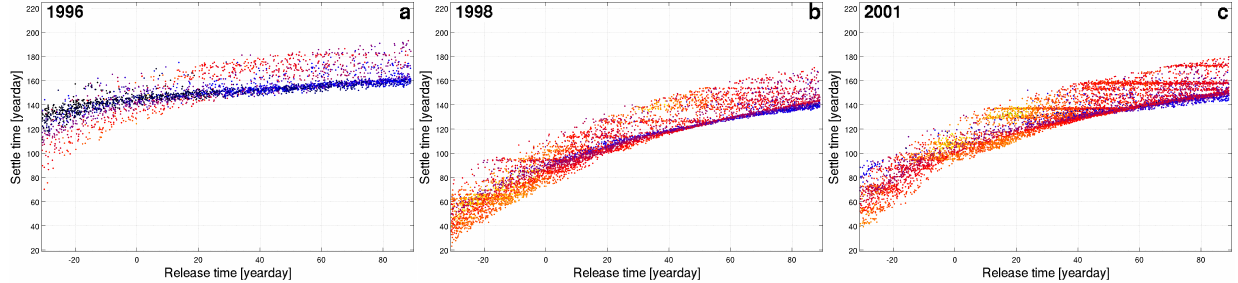
Figure 20: Settlement of particles in the western Wadden Sea, for prolonged numerical Figure 20. Settlement of particles in the western Wadden Sea, for prolonged numerical simulations (180 days). (a) 1996; (b) 1998; (c) simulations (180 days). (a) 1996; (b) 1998; (c) 2001. 5